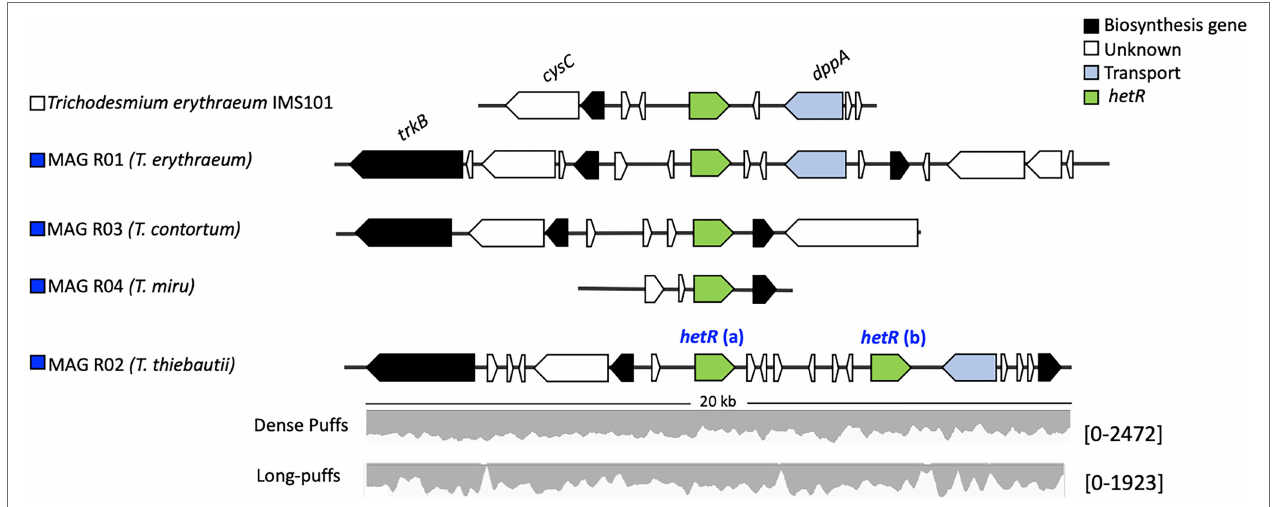
FIGURE 4 | The hetR gene clusters in Trichodesmium sp. The synteny of the hetR genes (green) and the neighboring genes of the cluster is conserved between the Trichodesmium MAGs and Trichodesmium erythraeum IMS101. MAG R02 ( Trichodesmium thiebautii ) contains two hetR genes. Raw read counts, listed within the brackets, were mapped to the hetR gene cluster of MAG R02 from both the dense and long puff